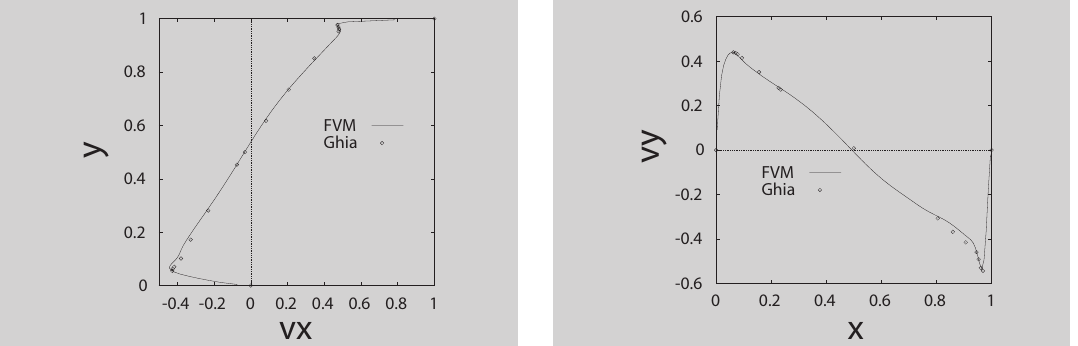
Figure 5: The profile of horizontal velocity vx through vertical centerline and vertical velocity vy through horizontal center- line (FVM with Power Law using m = 0.0001, n =